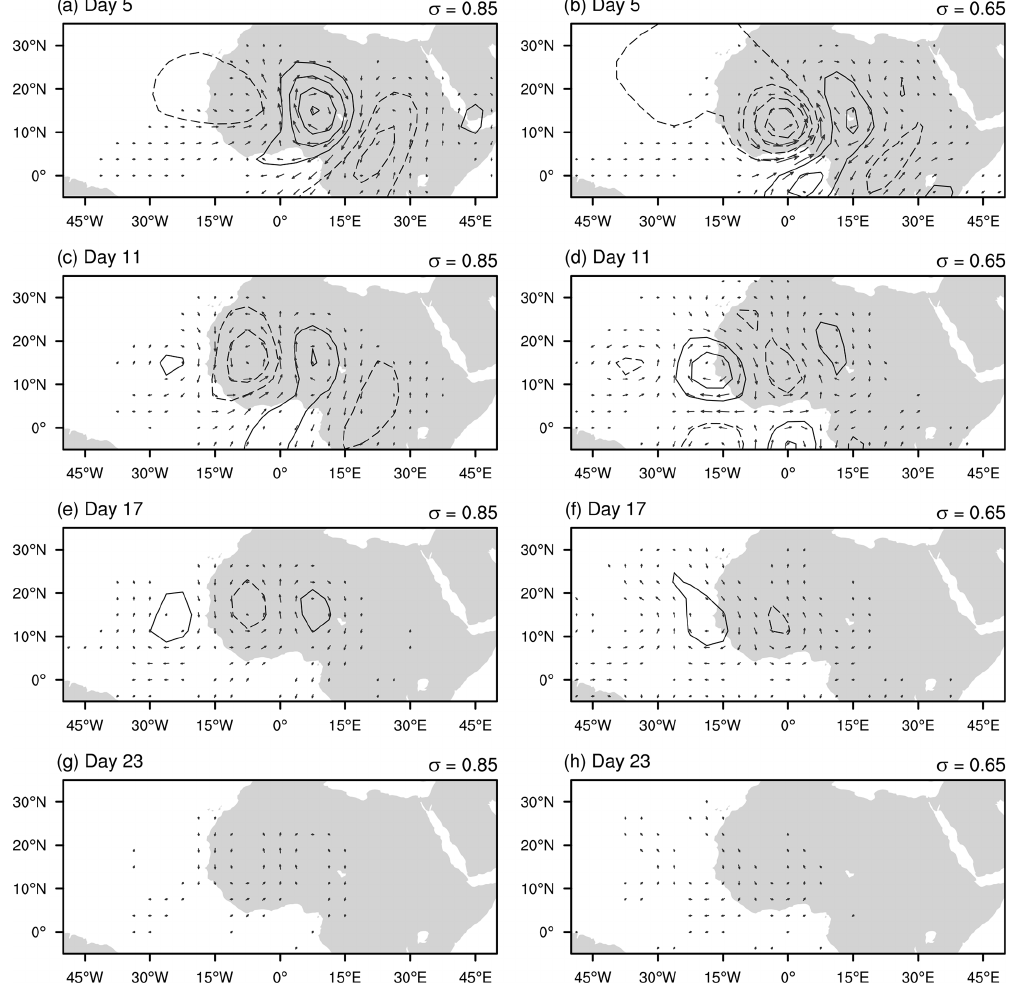
Figure 4. Streamfunction (interval 1 × 10 5 m 2 s − 1 with negative values dashed) and horizontal wind vectors at σ = 0 . 85 (a, c, e, g) and 0.65 (b, d, f, h) showing the wave response within the climatological composite basic state for days 5, 11, 17, and 23 from top to bottom.